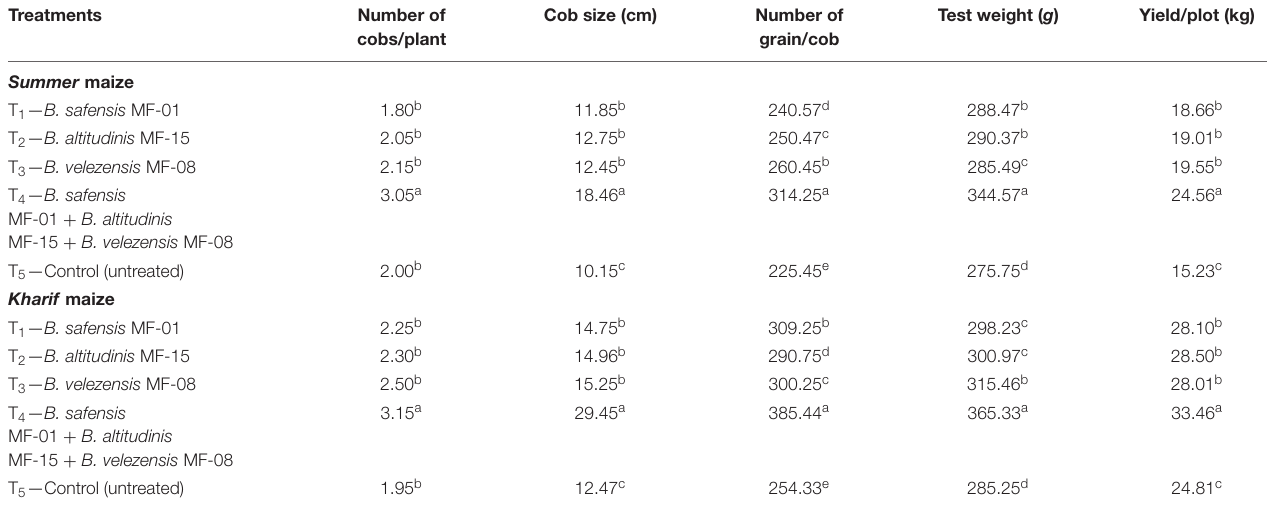
Cob size (cm) Number of Test weight ( g ) Yield/plot (kg) cobs/plant grain/cob